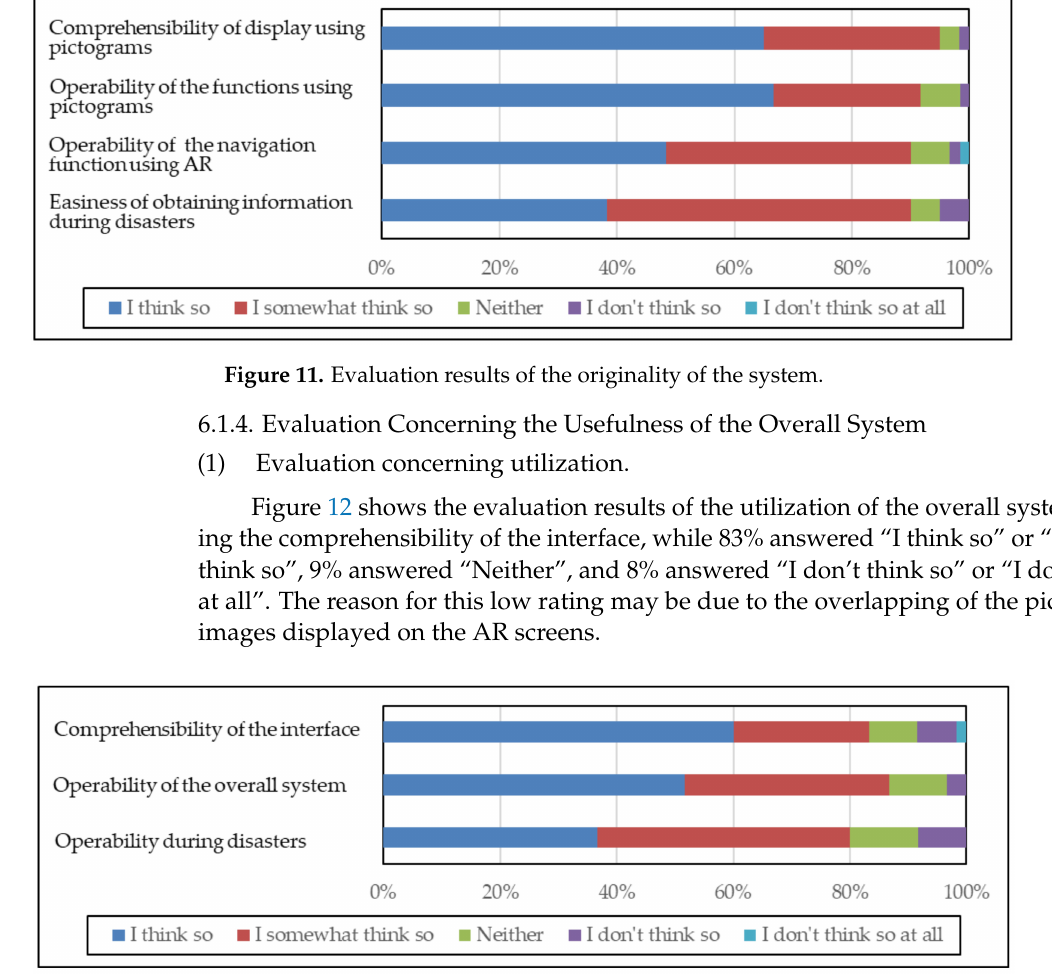
Figure 12. Evaluation results concerning the utilization of the overall